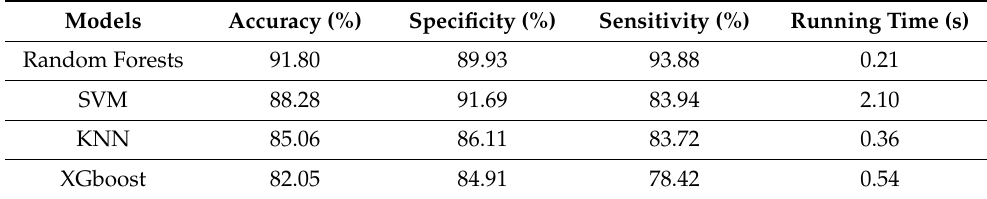
Table 2. The performance of sleep apnea judgment under different models.